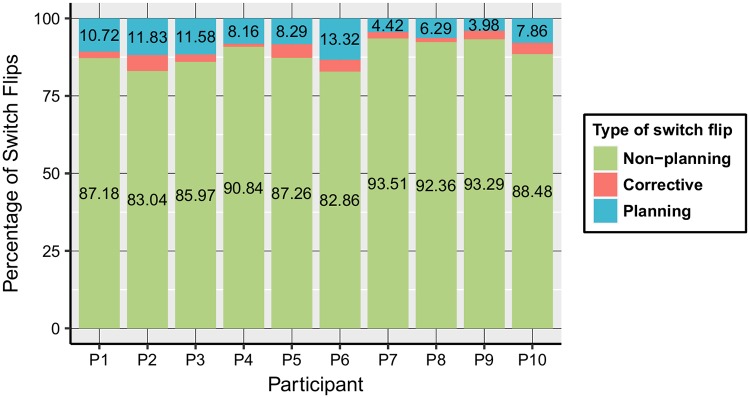
Overall composition of correct switch flips for participants.